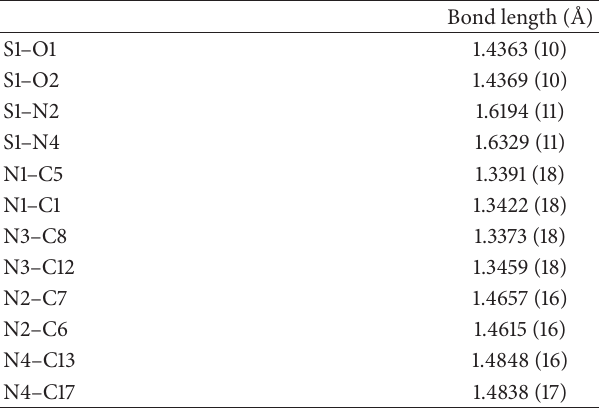
Table 2: Selected bond distances (˚A) for N(SO 2 pip)dpa.